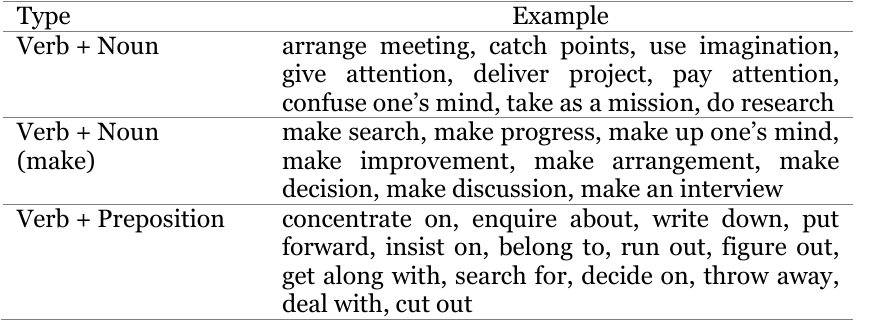
Sample Lexical Collocations Recognized in the Log Files